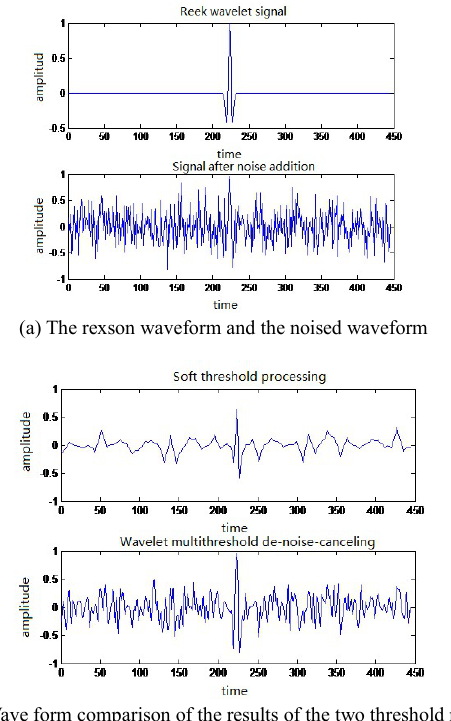
Figure 1. Rexson waveform and noise reduction waveform In Figure 1(a), the signal of the Rake wavelet after the